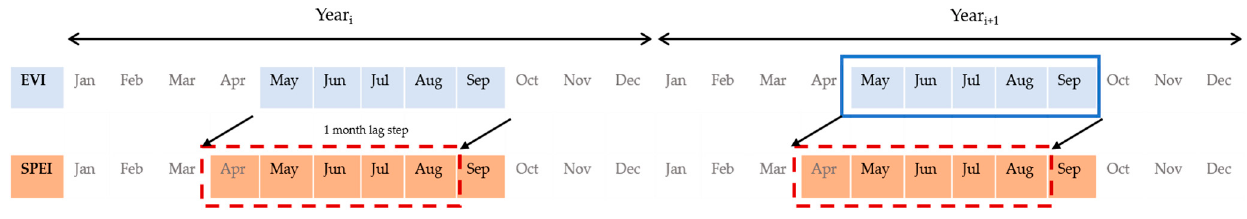
Figure 2. Example of calculating the correlation between the growing season EVI and SPEI with a 1-month lag step.